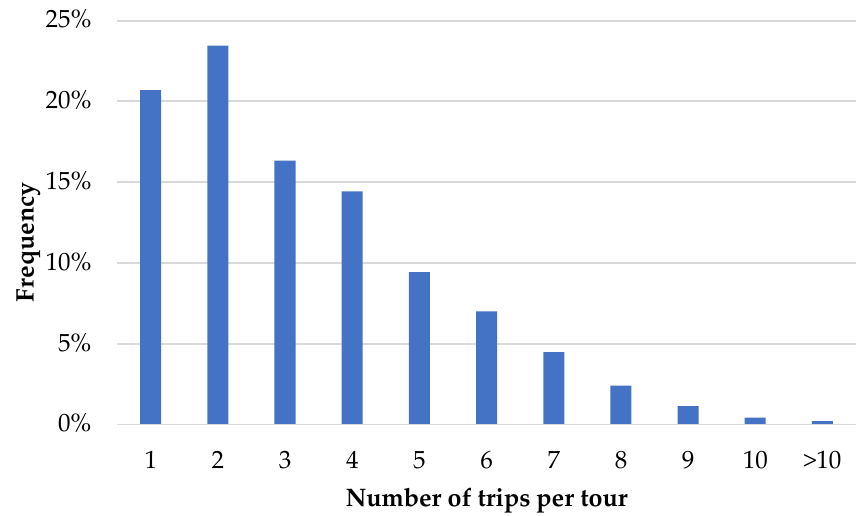
Figure 4. Number of trips per tour from Padua.